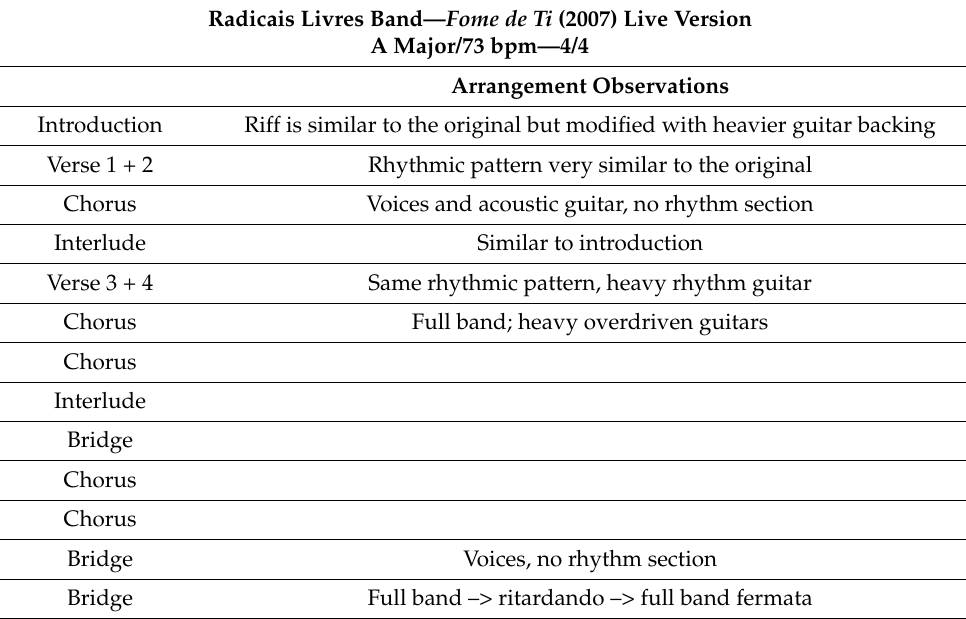
Table 4. Form and arrangement outline of Radicais Livres’ version of “Poder pra